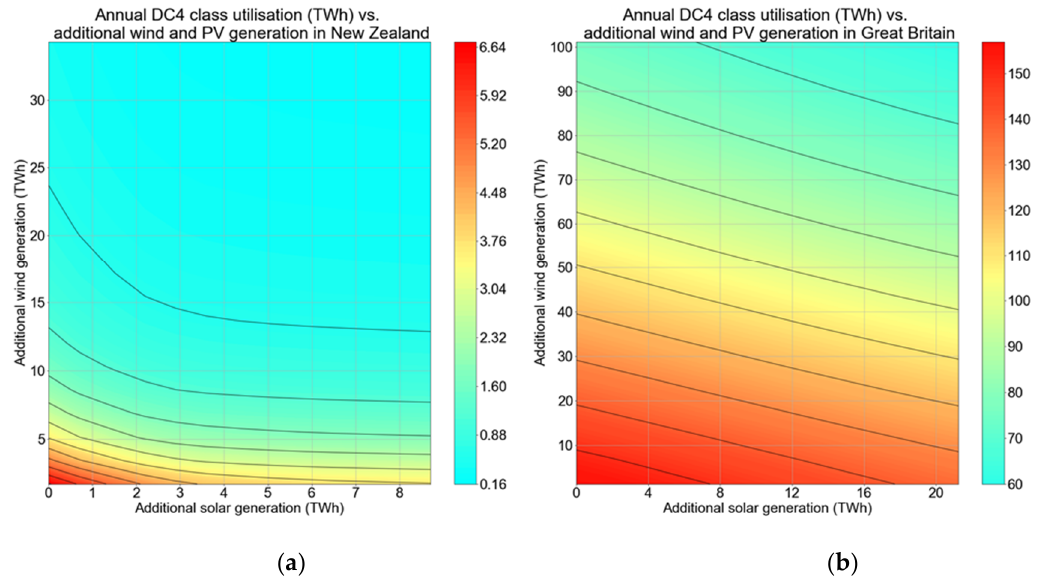
Figure 8. Annual generation from DC4 assets in ( a ) New Zealand and ( b ) Great Britain under different solar and wind generation scenarios—denoted by the maximum theoretical pre-curtailment generation of each technology in TWh per year.